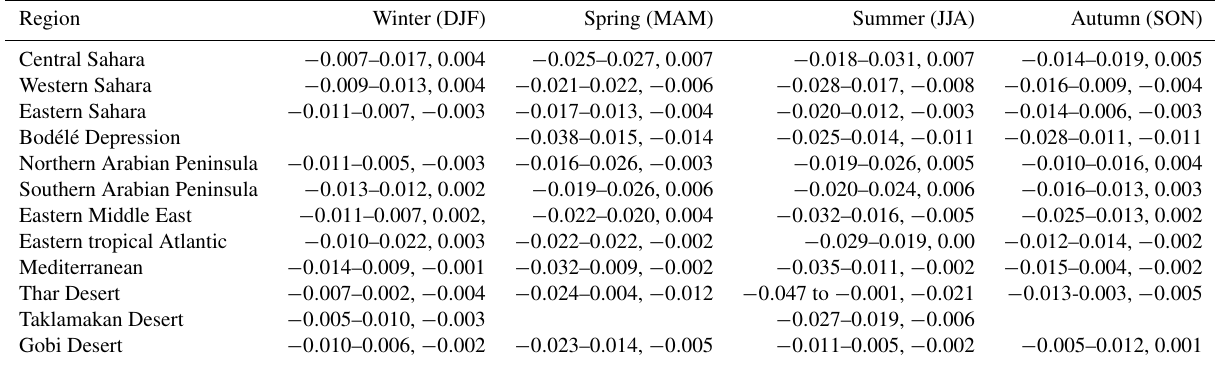
Table 2. Seasonal trends over 12 regions of interest. Each column includes the range of DOD trend (yr − 1 ) and the median DOD trend. Non-available values are shown in blank cells. The domains of the regions are depicted in Fig. 7.